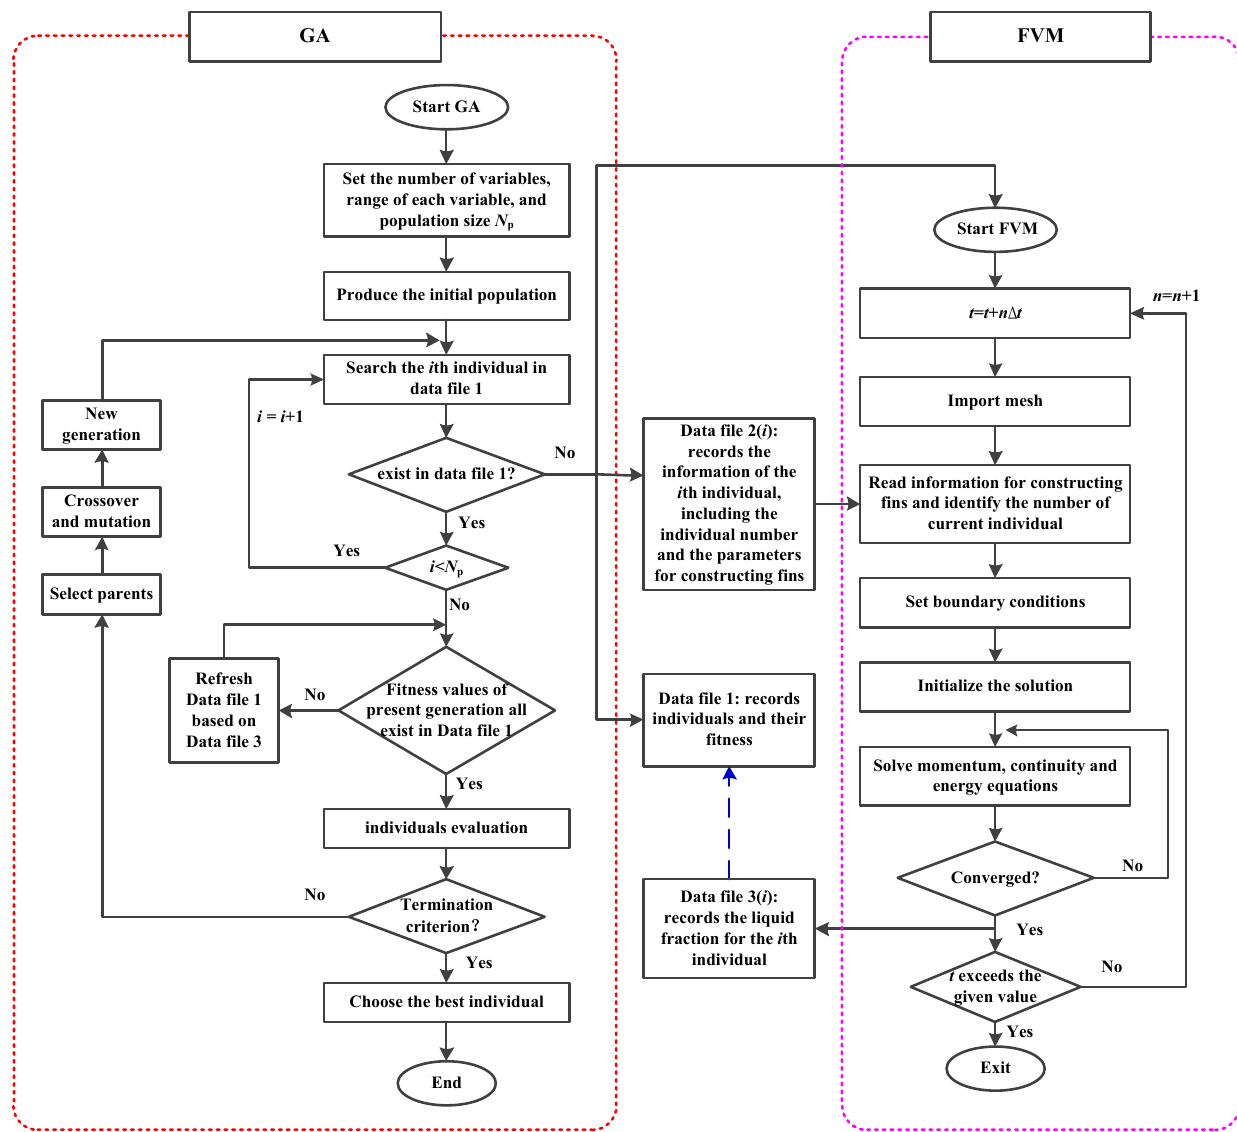
Figure 4. The flowchart of the optimization process.